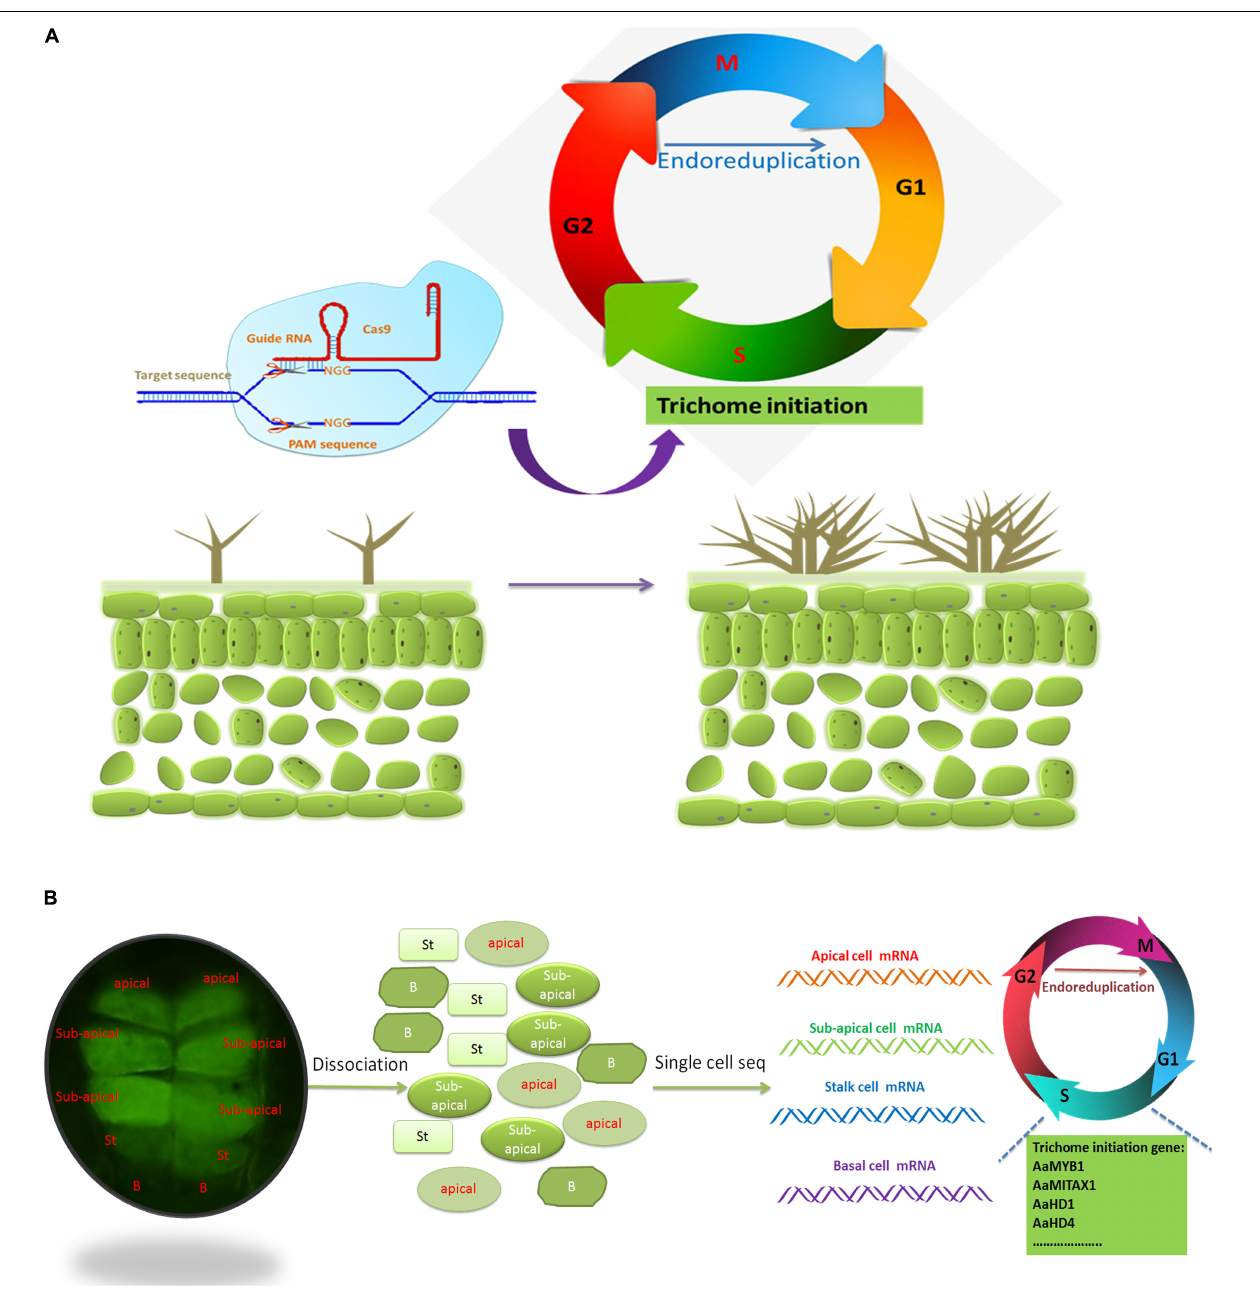
FIGURE 7 | CRISPR-Cas9 and single-cell sequencing may help reveal the development of trichomes. (A) CRISPR-Cas9 may be a promising technique for producing multiple trichomes by editing the redundant cyclin genes involved in trichome development. G1, gap 1; G2, gap 2; M, mitosis; S, synthesis. (B) Single-cell sequencing can be used to elucidate the mechanism underlying trichome development. Autofluorescence of glandular trichomes on the buds of A. annua , as revealed via a fluorescent isothiocyanate (FITC) filter ( λ ex = 480 nm; λ em = 535 nm). Each trichome of A. annua is composed of ten cells: one pair of apical cells, two pairs of subapical cells, one pair of stalk cells and one pair of base cells. The base cells do not autofluorescence. Advanced single-cell mRNA sequencing (mRNA-seq) can be used to restore the developmental process of each cell of glandular trichomes, and the main genes involved in trichome development encode cyclins. St, stalk cell; B, base